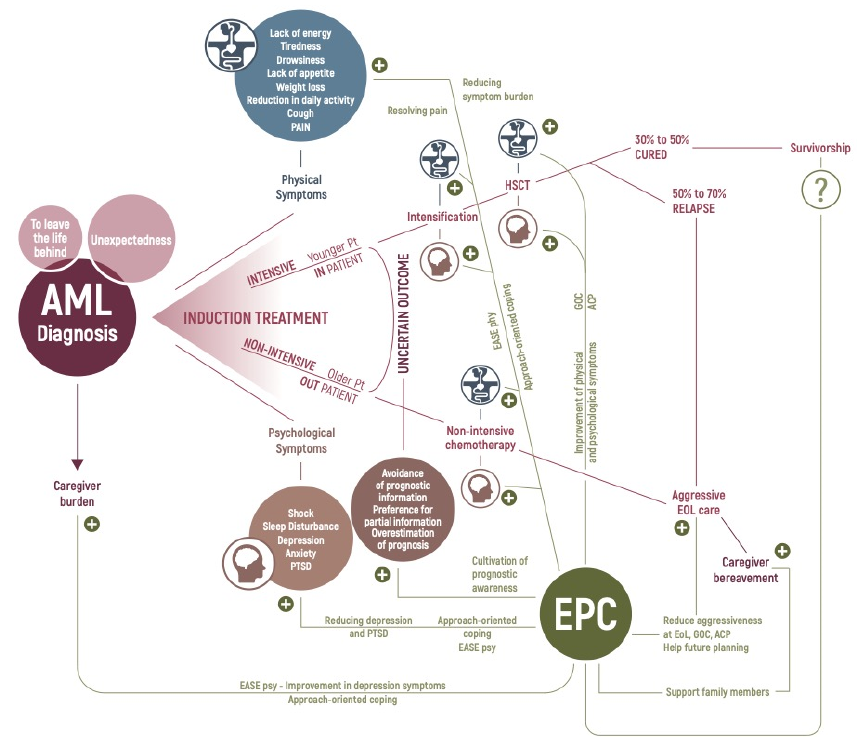
Figure 1. Effects of the early integration of palliative care on the disease trajectory of patients with acute myeloid leukemia. AML = acute myeloid leukemia; Pt = patients; PTSD = post-traumatic stress disorder symptoms; EASE = Emotion And Symptom-focused Engagement; psy = psychother- apeutic intervention; phy = screening of physical symptoms with targeted referral to palliative care; EPC = early palliative care; HSCT = hematopoietic stem cell transplant; GOC = goals of care discussions; ACP = advance care planning; EOL = end-of-life; ? = doubts about the possibility that EPC might be the best model for providing assistance and support to the population of AML patients cured of long-term therapy-related symptoms and mental health